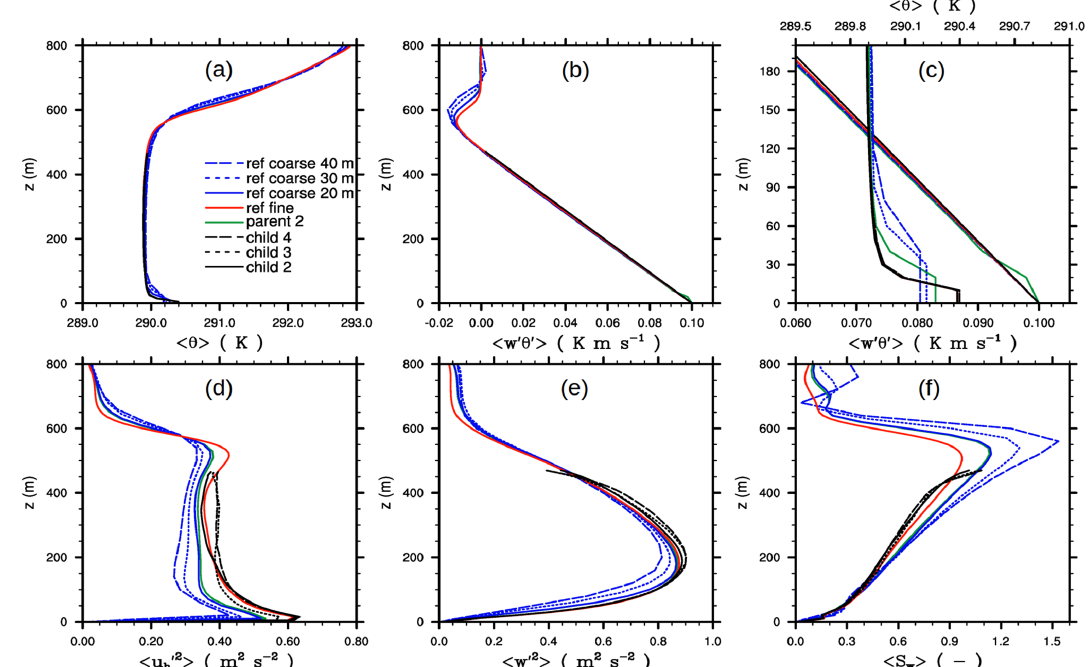
Figure 6. The 30min time-averaged and horizontally averaged profiles of (a) (cid:104) θ (cid:105) and (b) (cid:10) w (cid:48) θ (cid:48) (cid:11) . (c) A close-up view of (cid:104) θ (cid:105) and (cid:10) w (cid:48) θ (cid:48) (cid:11) . (d) Variance of the horizontal velocity component, (e) variance of the vertical velocity component, and (f) skewness of the vertical velocity component after 4h of simulated time. Note the second upper abscissa in (c) . Profiles are shown for the grid-spacing ratio of 2, 3, and 4 for the respective child domains, indicated by the respective numbers. All of these child domains have the same resolution as the fine-grid reference simulation. The corresponding profiles from the coarse-grid reference simulations for the 20m, 30m, and 40m grid spacing are indicated the same. For the sake of clarity, the resulting profiles for the parent domain are only shown for the grid-spacing ratio of 2. Angle brackets indicate a horizontal average over the